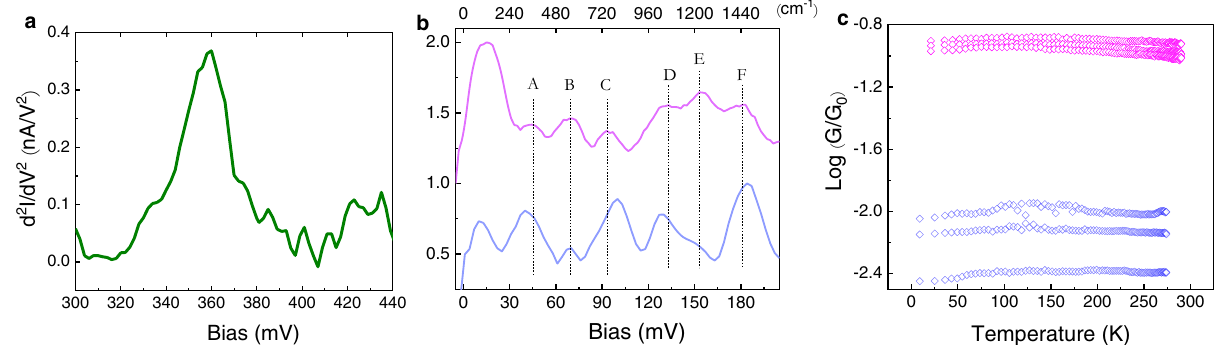
Fig.3|CharacterizationoftheMEJs.a AllIETSspectrashowthecharacteristicC-H stretch of alkane chains at 360meV. b IETS in the fi ngerprint region of repre- sentative C8 (magenta) and C10 (blue) junctions, with the following assignment of modes 31,33 : (A) Bi-S vibration, (B) C-S wag, (C) C-S stretch, (D) C-C stretch, (E) CH 2 wag, (F) CH 2 scissor. c The effect of temperature on the conductance of three